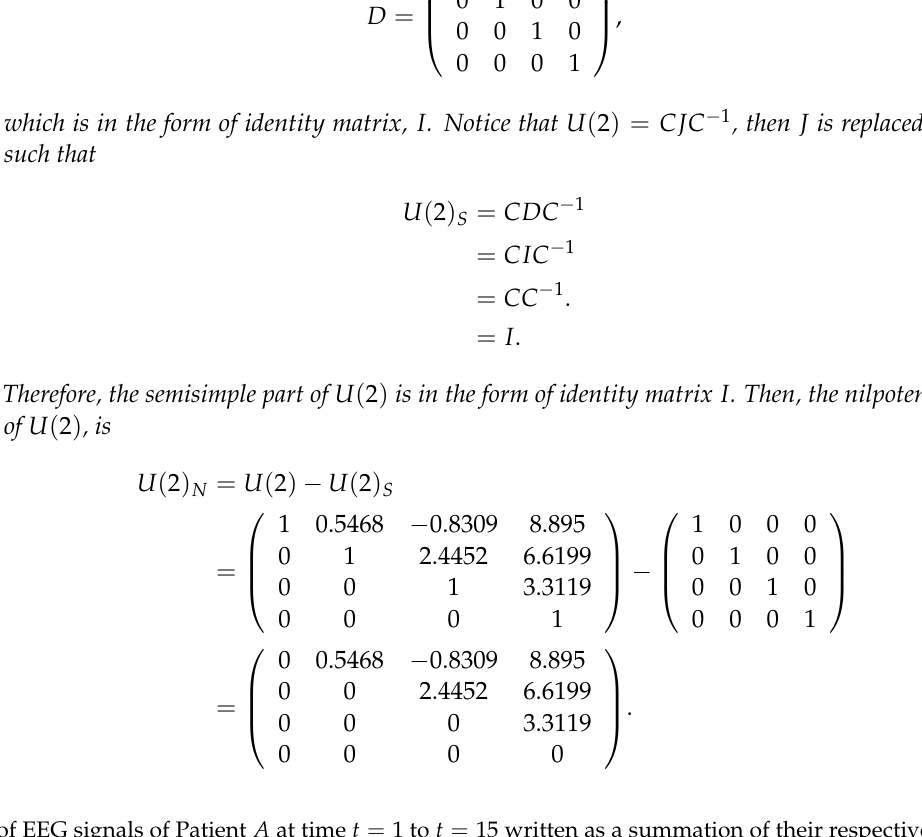
Table 8. Unipotent matrix of EEG signals of Patient A at time t = 1 to t = 15 written as a summation of their respective semisimple and nilpotent